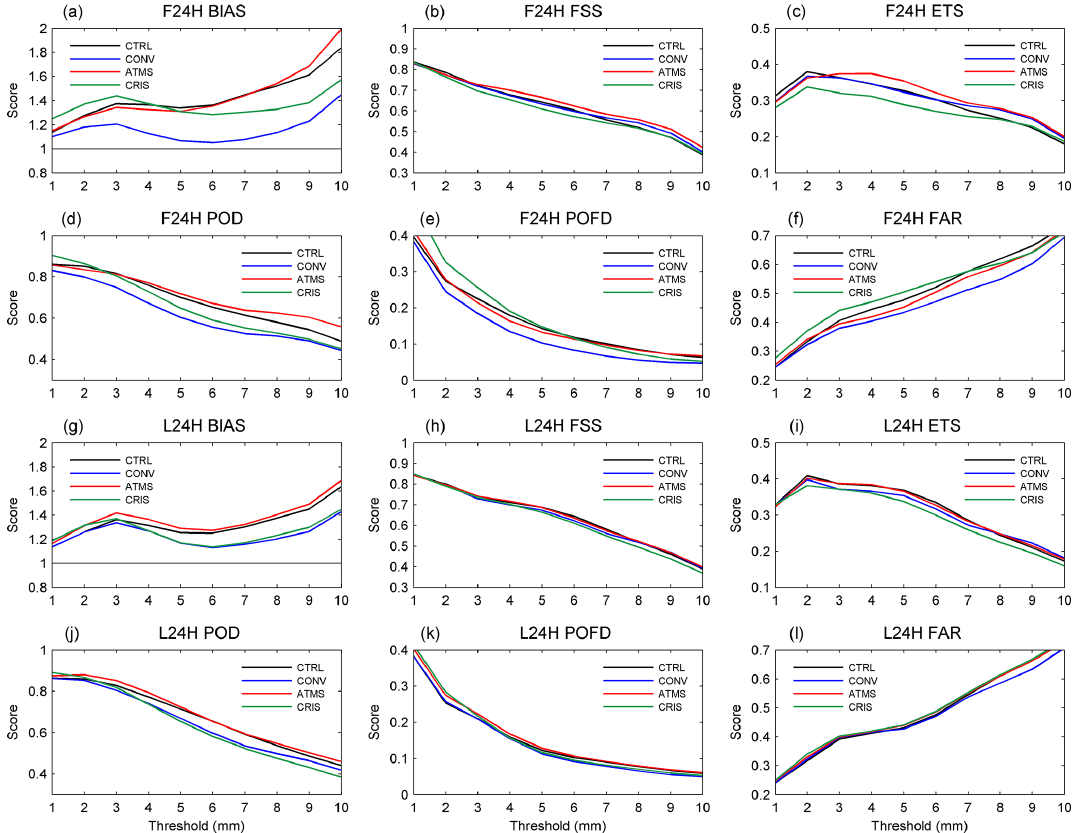
Figure 7. Monthly and domain average validation statistics for (a–f) F24H forecast and (g–l) L24H forecast. (a, g) are bias score; (b, h) are fraction skill score; (c, i) are equitable threat score; (d, j) are probability of detection; (e, k) are probability of false detection; (f, l) are false alarm ratio.